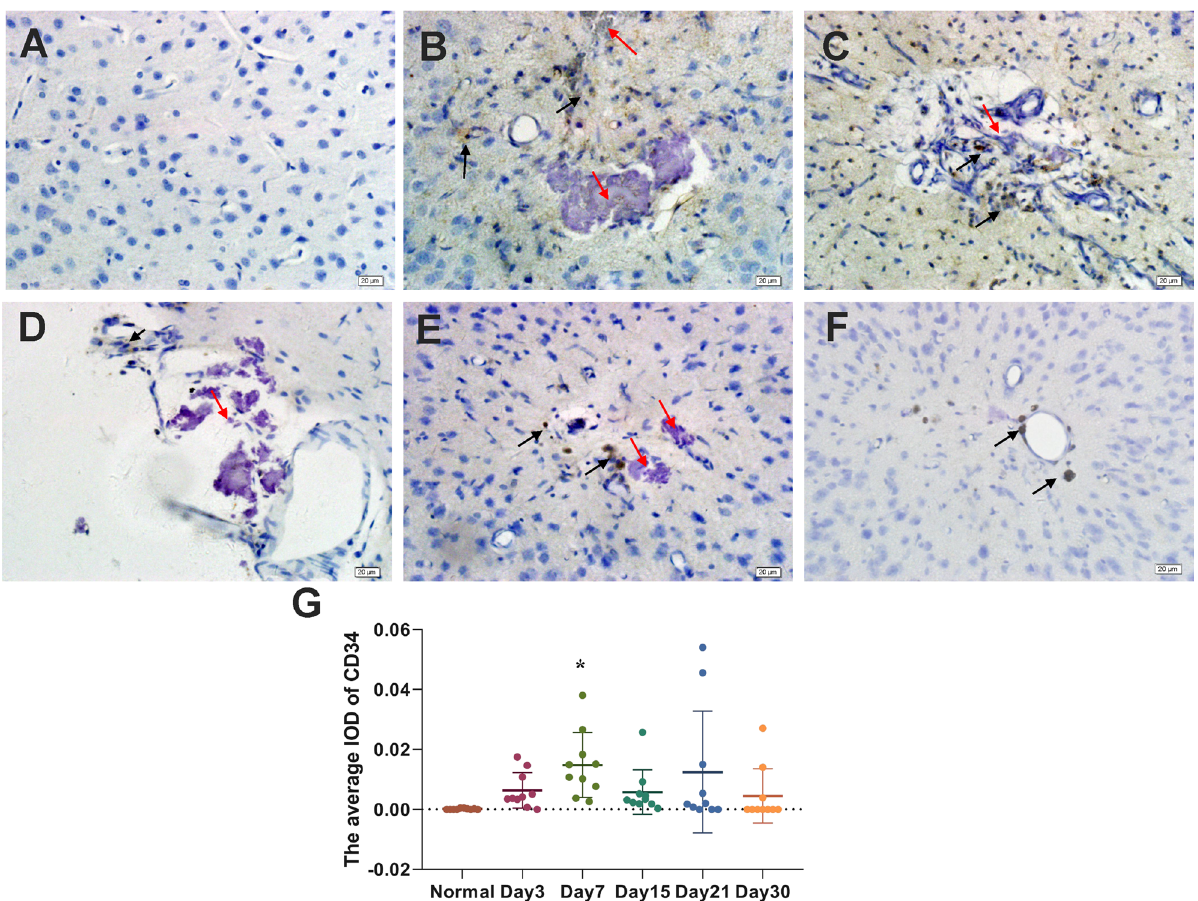
Figure 3. Immunohistochemical staining images showing CD34 expression in ( A ) normal mouse brain tissue and ( B – F ) mouse brain tissue on days 3, 7, 15, 21 and 30 days, following the pTBI. ( A ) CD34 was not expressed in normal mouse brain tissue. CD34-positive cells and blood vessels (brown; black arrows) became visible at the injury site (red arrow) on days ( B ) 3 and ( C ) 7. ( D ) After 15 days, CD34 expression at the injury site (red arrow) decreased. ( E ) CD34 expression at the injury site could not be detected on day 21. Instead, black hemosiderin particles (black arrows) were observed at the injury site. ( F ) Some black hemosiderin particles remained visible at the injury site on day 30. ( G ) Immunohistochemical results of CD34 were analyzed by Image-Pro Plus 6.0 software. The average density (IOD) of CD34-positive cells in normal mouse brain tissue and in mouse brain tissue on days 3, 7, 15, 21 and 30 days, following pTBI. The n = 10/group was used for calculating the average IOD. Comparisons between groups were performed using the Kruskal–Wallis H test followed by Bonferroni post-hoc